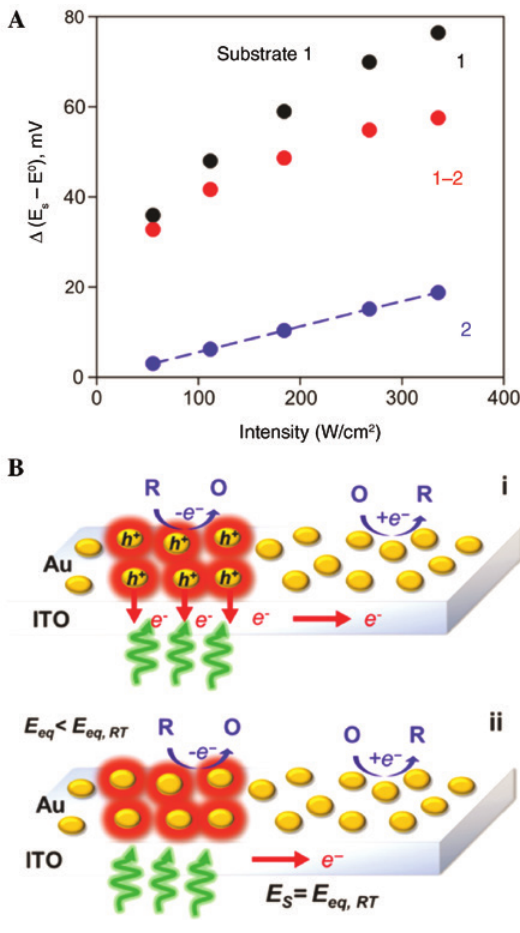
Figure 12: Proposed mechanisms for photoinduced oxidation based on the contributions of hot holes and thermal effects. (A) Isolating hot hole contribution for photoinduced oxidation by comparing how the reaction potential changes at various laser intensities. Substrate 1 (black) contains contributions from hot holes and heating. Substrate 2 (blue) only has thermal contributions. Hot hole contribution for substrate 1 (red) is isolated by subtracting out the thermal contributions. (B) Pictorial depiction of proposed mechanisms: (i) hot hole generation and (ii) thermal contribution leading to altered equilibrium potential of redox couple. Reprinted with permission from Ref. [155]. Copyright 2018 American Chemical